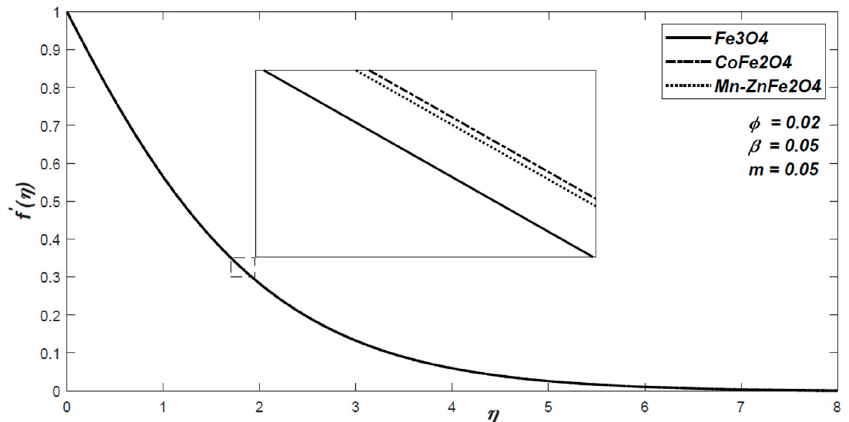
Figure 2. The variation of the nondimensional velocity for three types of nanoparticles with volume fraction φ = 0.02.